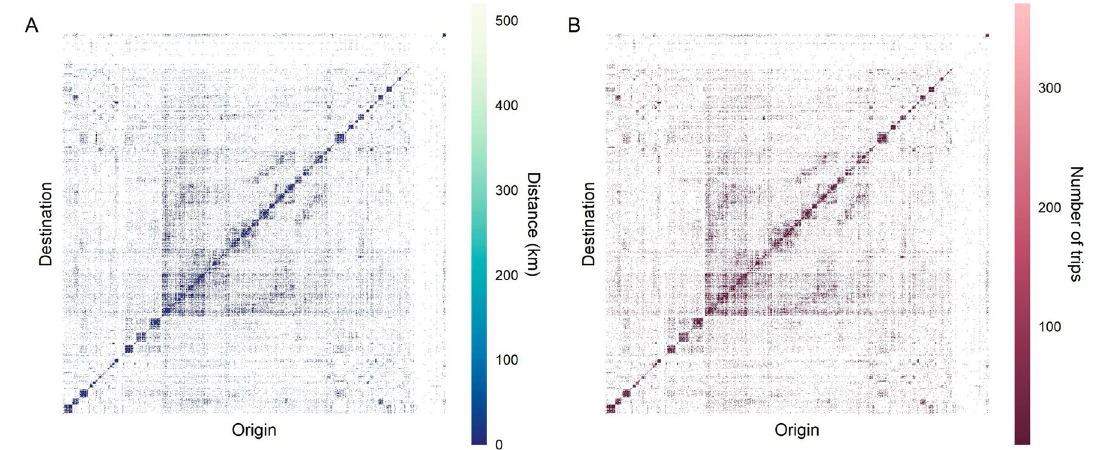
Figure 1. Overall inter-zone activity for all trip types ( A D matrix, B OD matrix).